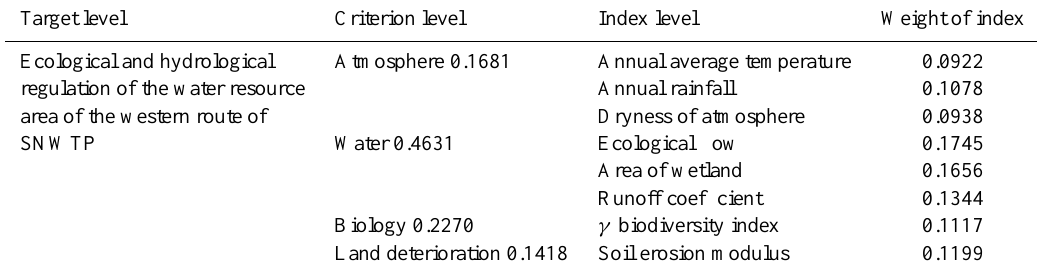
Table 2. Environmental and ecological diagnostic indices of the western route of SNWTP.